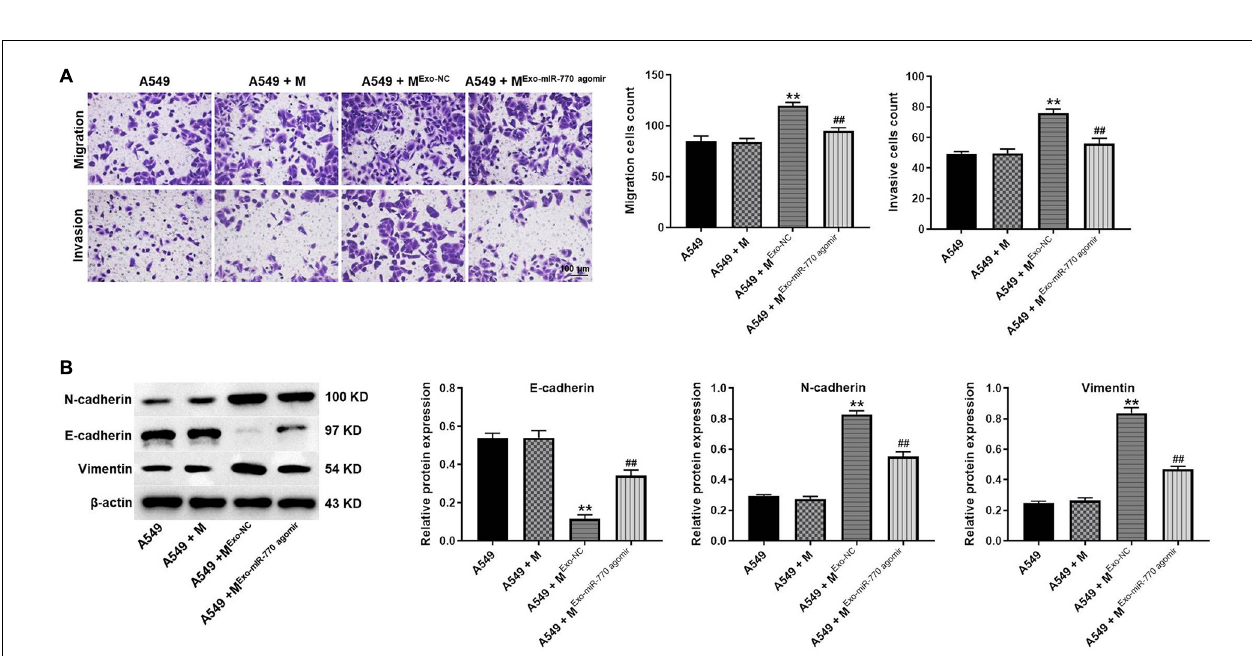
FIGURE 6 | Exosomal miR-770 significantly inhibited the migration, invasion and EMT process of NSCLC cells via suppressing the polarization of M2 macrophages. (A) A549 cells were co-cultured with macrophages, M exo − NC or M Exo − mIR − 770 agomir . Then, the migration and invasion of NSCLC cells was tested by transwell assay. (B) The protein levels of E-cadherin, N-cadherin and vimentin in A549 cells were detected by western blot. The relative expressions were quantified by normalizing to β -actin. N = 3; ** P < 0.01 compared to A549 cells, ## P < 0.01 compared to A549 + M exo − NC .